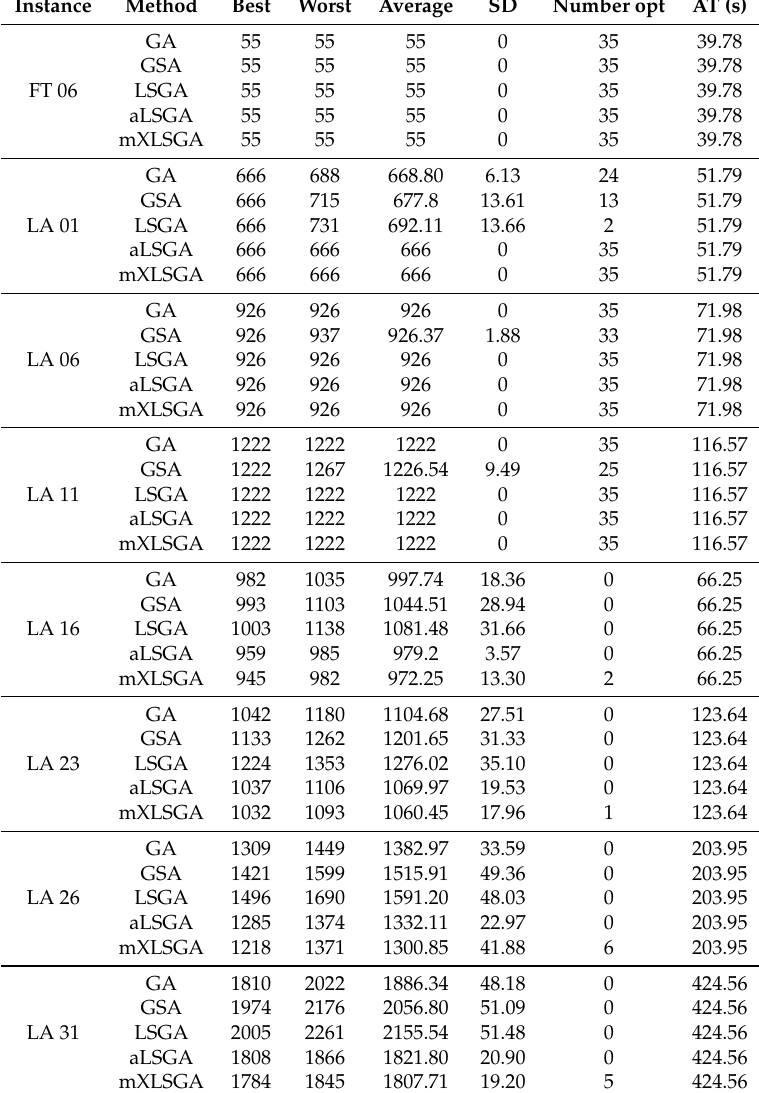
Table 8. Result of 35 independent executions of each method considering as stopping criterion the execution time. In this case, in each execution, all techniques are performed for, at least, the same amount of time as the technique that takes the longest time in the considered